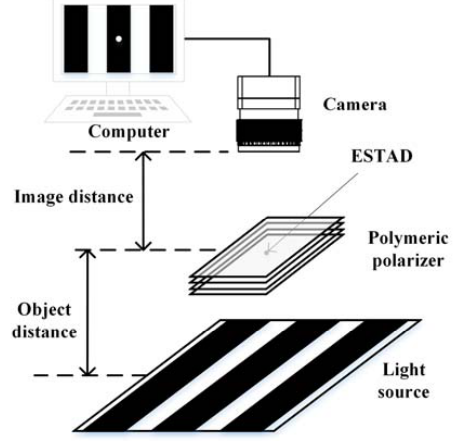
Figure 2. Schematic of the experimental setup.